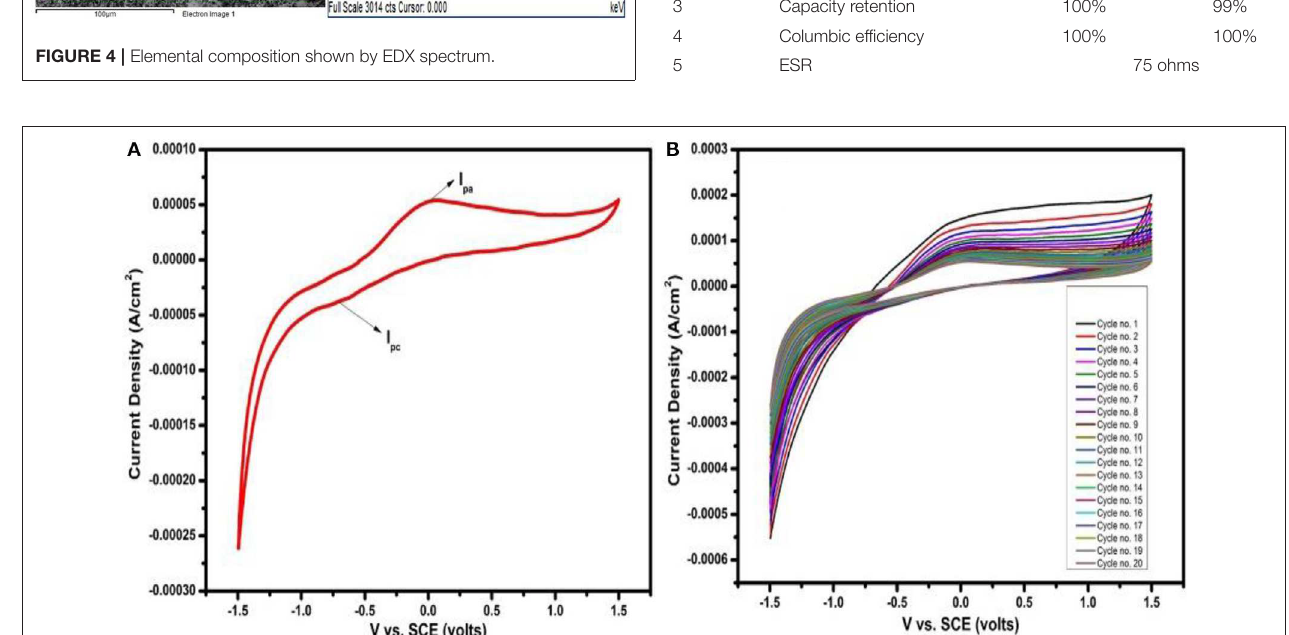
Frontiers in Chemistry |